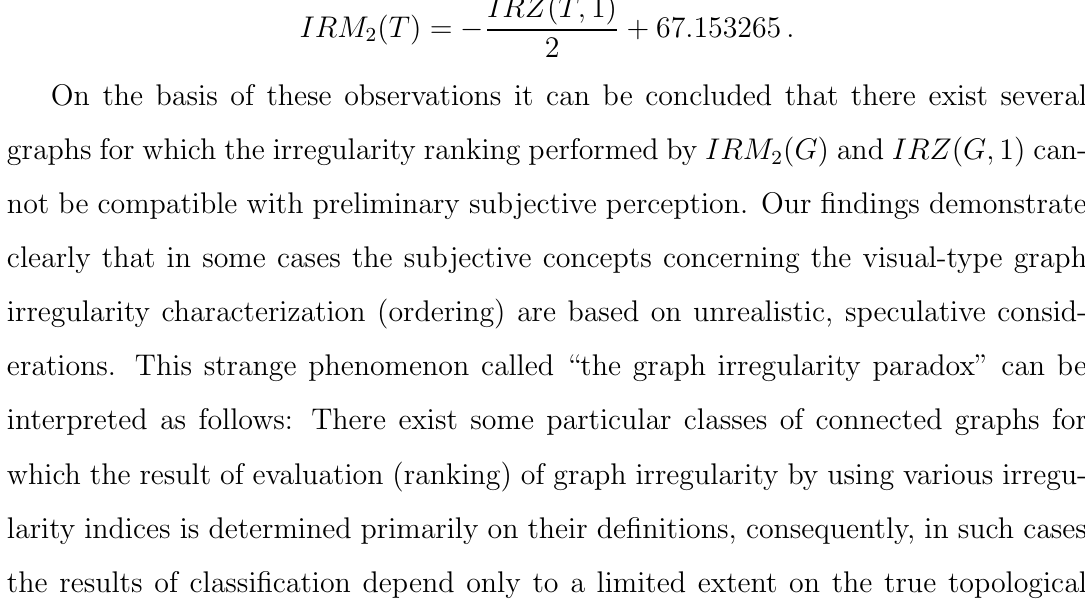
( G ) for 8 trees. 2 ( G ) indices. This is due to the fact 2